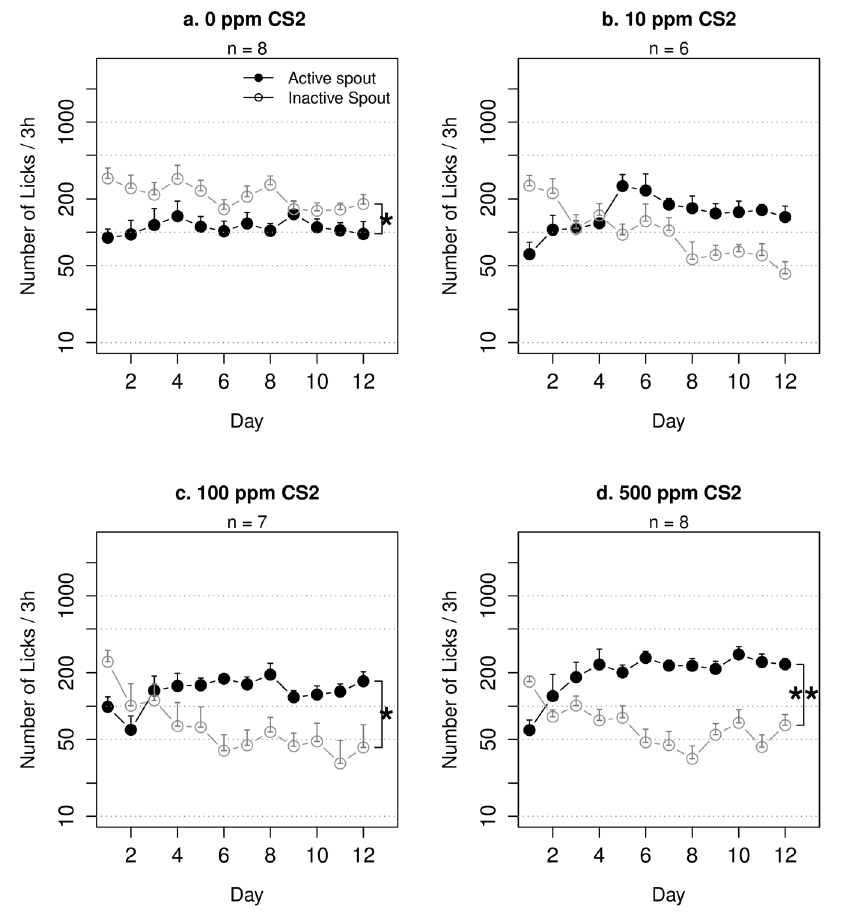
Fig. 2. Nicotine self-administration with an olfactogustatory cue and CS 2 in adolescent rats. Adolescent rats self-administered i.v. nicotine with contingent olfactogustatory cue containing different concentrations of CS 2 . Rats that received only the olfactogustatory cue (a) licked less on the active spout. With increasing concentration of CS 2 included in the olfactogustatory cue, the number of licks on the active spout took fewer sessions to surpass that on the inactive spouts (10 ppm: 4 sessions, 100 ppm: 3 sessions, 500 ppm: 1 session). *: p , 0.05; **: p , 0.01, repeated measures